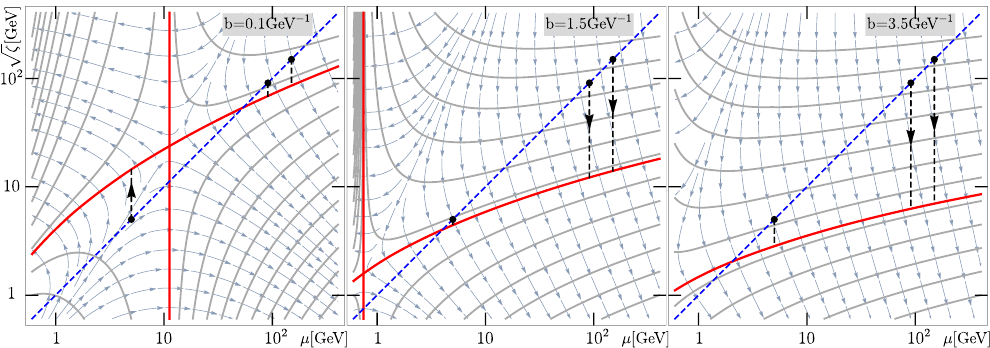
Figure 2 . In the ( (cid:16); (cid:22) ) plane we show the force-lines of the TMD evolution (cid:12)eld E at di(cid:11)erent values of b (in grey, with arrows). The thick continuous gray lines are null-evolution (equipotential) lines. Red lines are the equipotential lines that de(cid:12)ne the saddle point. The red line which crosses each panel from left to right is the special evolution curve where the TMD are de(cid:12)ned. The blue dashed lines in each plot correspond to the (cid:12)nal scale choice ( (cid:22) f ; (cid:16) f ) for typical experimental measurements. The black points indicate the initial evolution scales for Q = 5, 91 and 150 GeV cases. Black dashed lines with arrows are paths of evolution implemented in eq.